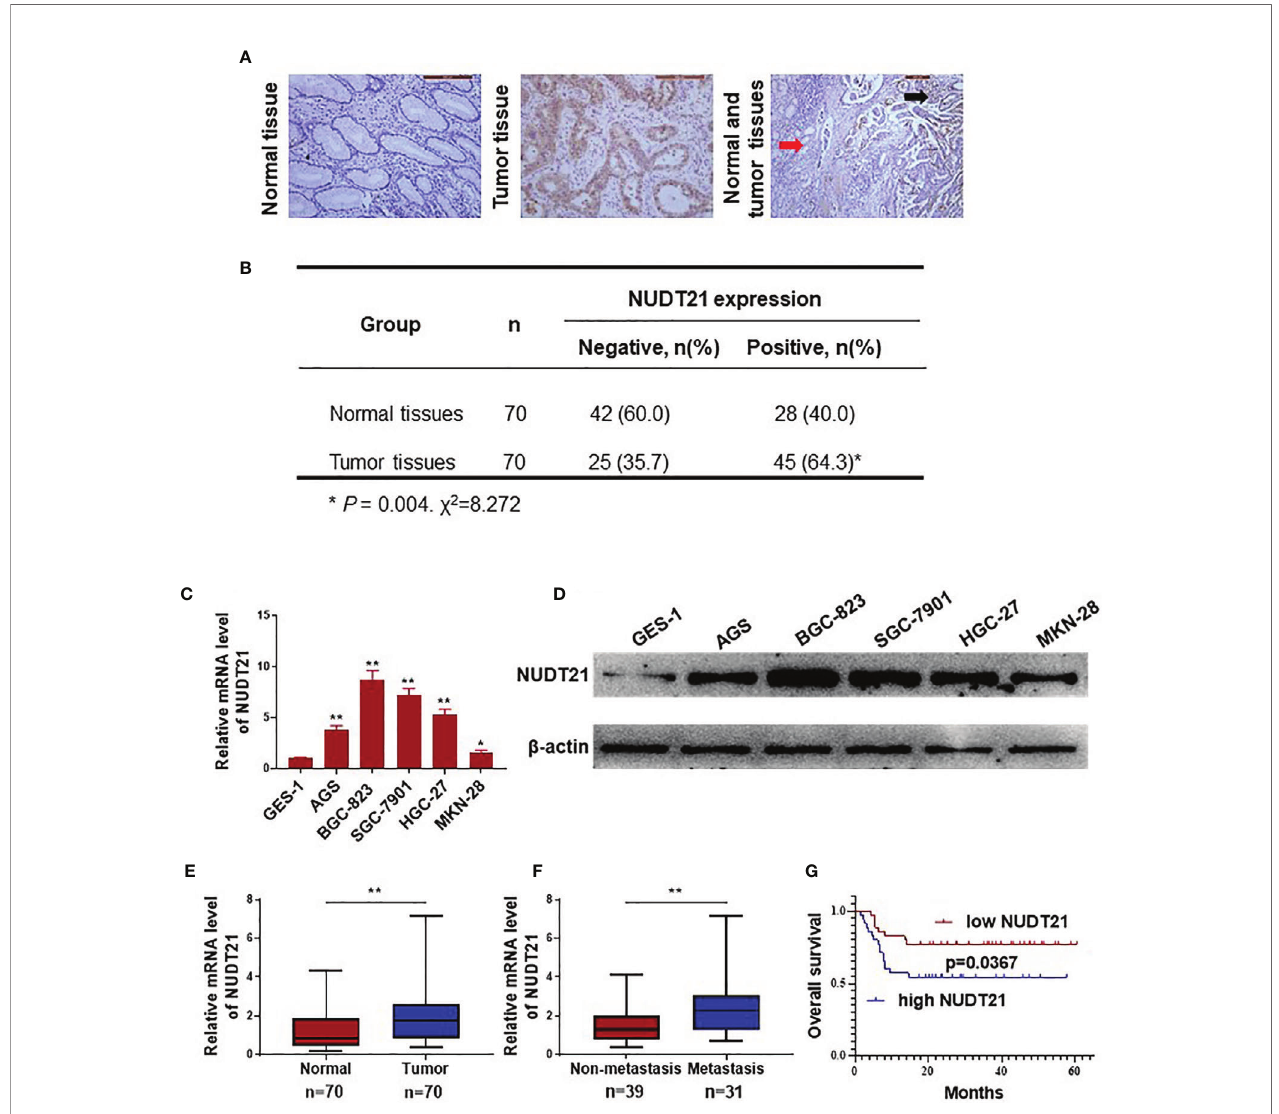
FIGURE 1 | Expression of NUDT21 in human gastric cancer/normal gastric tissue samples and cell lines. (A, B) Protein levels of NUDT21 in 70 gastric cancer tissues and 70 normal gastric tissues were examined by immunohistochemistry. The magni fi cations were 200 and 100 respectively. Red arrows: normal gastric tissue; black arrows: gastric cancer tissue. (C) Relative mRNA levels of NUDT21 in gastric cancer cells AGS, BGC-823, SGC-7901, HGC-27, MKN-28 and normal gastric cell GES-1 were examined by RT-qPCR. GAPDH was used as control. (D) Protein levels of NUDT21 in gastric cancer cells AGS, BGC-823, SGC-7901, HGC-27, MKN-28 and normal gastric cell GES-1 were examined by western blot. b -Actin was used as control. (E) mRNA levels of NUDT21 in 70 gastric cancer tissues and 70 normal gastric tissues were examined by RT-qPCR. (F) mRNA levels of NUDT21 in 31 gastric cancer tissues from patients with metastasis and 39 gastric cancer tissues from patients without metastasis were analyzed by RT-qPCR. (G) Kaplan-Meier curves showed the overall survival (OS) rates in gastric cancer patients with high and low levels of NUDT21. * P < 0.05; ** P <